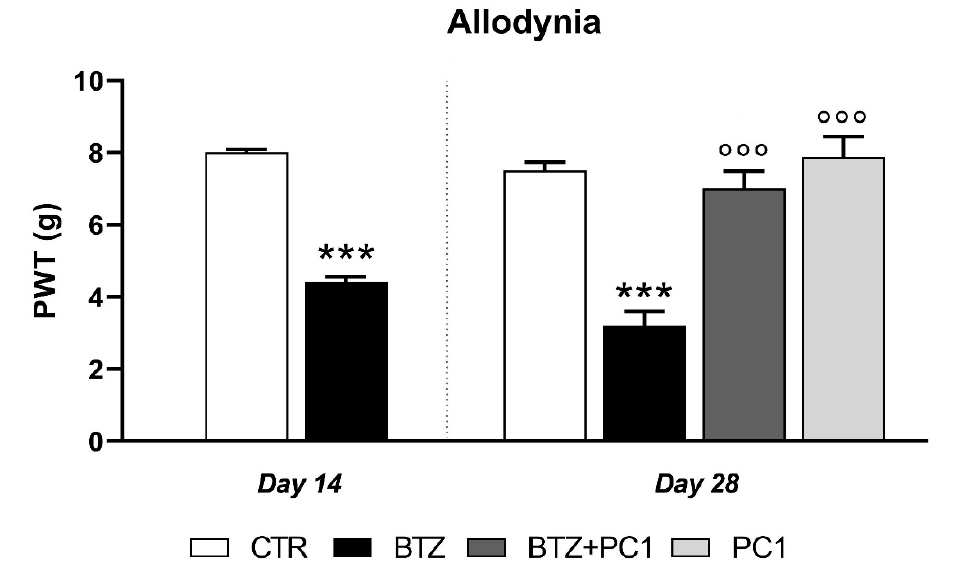
Figure 1. Mechanical allodynia induced by BTZ treatment (0.4 mg/kg, 3 times/week for two (Day 14), or four weeks (Day 28)) and effect of PC1. PC1 (150 μ g/kg s.c., twice daily) was administered alone or together with BTZ for 14 days, starting from day 14 (established mechanical allodynia) until day 28. Data represent the mean ± SEM of paw withdrawal threshold (PWT, in grams) from six mice/group. (*** p < 0.001 vs. CTR; °°° p < 0.001 vs. BTZ; analyzed by t-test (Day 14) or one-way ANOVA followed by Bonferroni’s multiple comparison test (Day 28)).